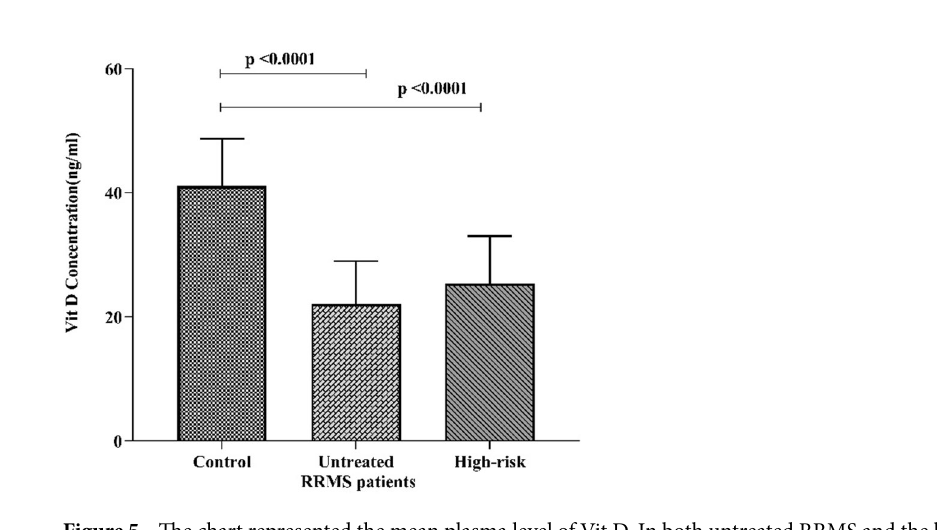
Figure 5. The chart represented the mean plasma level of Vit D. In both untreated RRMS and the high-risk groups the concentration of Vit D decreased markedly (Mann Whitney, P < 0.0001). The mean concentration of Vit D in the healthy control group (42.23 ng/ml, sufficient), in untreated RRMS (17.40 ng/ml, insufficient), and in the high-risk group was (22.58 ng/ml,